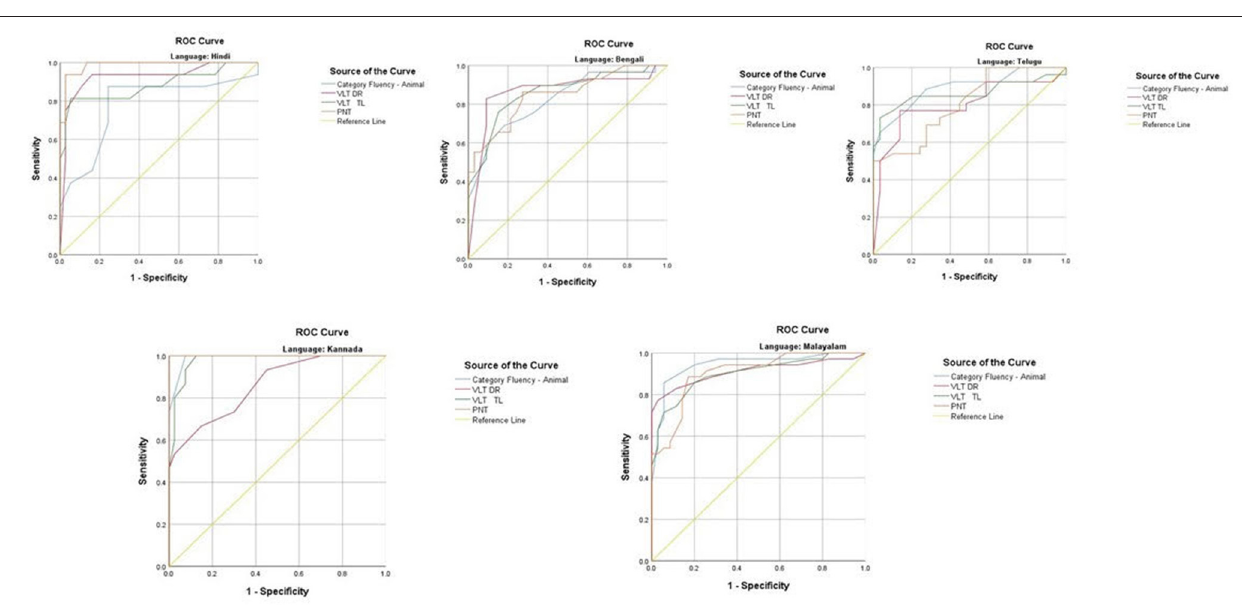
FIGURE 2 | Receiver operating curve (ROC) of Category Fluency-Animal, Verbal Learning Test: Delayed Recall and Total Learning (VLT DR and VLT TL), and Picture Naming Test (PNT) in diagnosing dementia across five languages. sensitivity and specificity of various cognitive domains in five Indian languages are provided separately. This is crucial for the diagnosis of dementia subtypes: AD, VaD, and FTD that have characteristic cognitive profiles. While AD is a disorder of memory especially in the early stages (54), VaD is characterized by prominent executive dysfunction (55) and frontotemporal dementia syndromes present with language and/or executive function impairment (56). The advantage of inclusion of tests